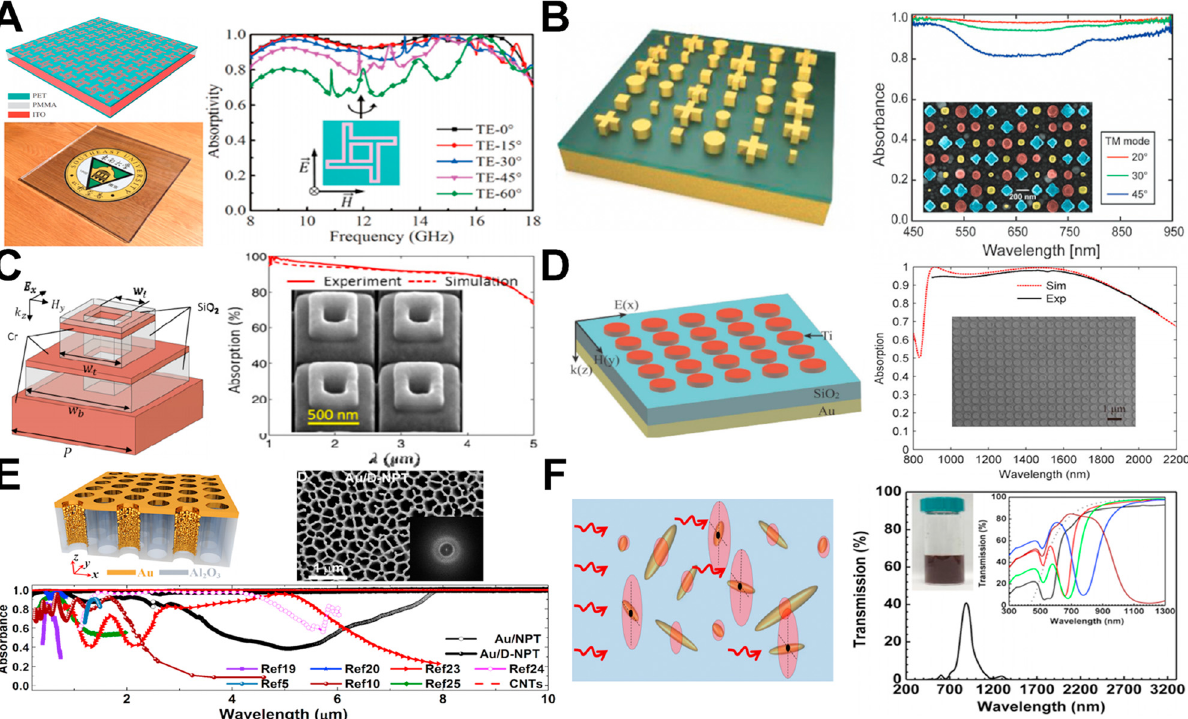
Figure 8: Various broadband absorber designs. (A) A windmill-patterned transparent broadband microwave absorber, and its measured absorptivity at different incident angles. Adapted with permission from Ref. [89]. Copyright 2017, AIP publishing. (B) A metasurface with